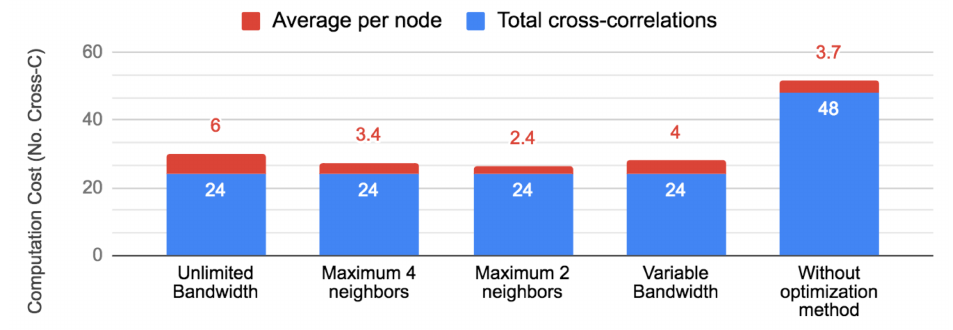
Figure 14. Computational cost in terms of number of cross-correlations computed by nodes. Comparison between our proposed communication-reduced method and communication pattern without reduction.Note that, in the case “unlimited bandwidth”, only 4/13 nodes computed cross-correlations, and, in the case “without optimization method”, all 13 nodes computed cross-correlations.